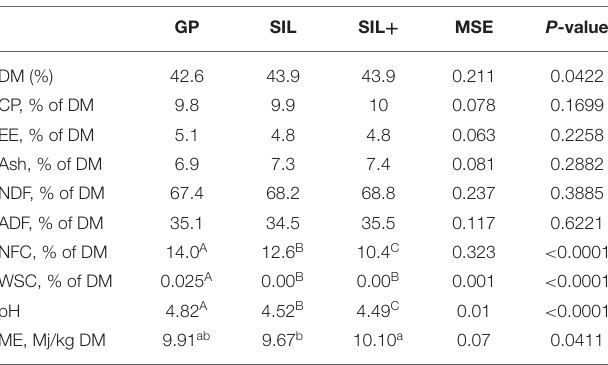
TABLE 1 | Impact of ensiling with or without L. plantarum 5BG on chemical composition and pH of grape pomace.